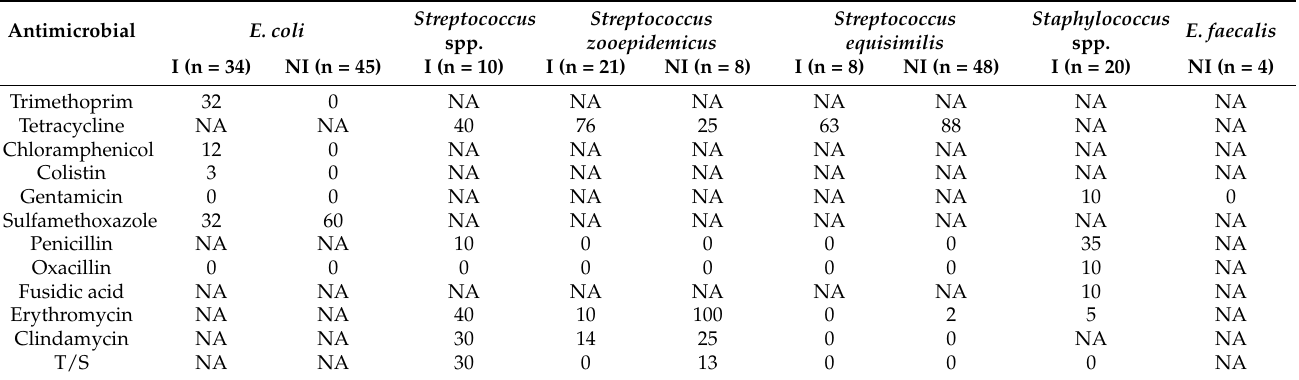
Table 6. Percentage of antimicrobial-resistant isolates of Escherichia coli , Streptococcus spp., Streptococ- cus equi subsp. zooepidemicus , Streptococcus equisimilis , Staphylococcus spp., and Enterococcus faecalis from the vaginas of healthy mares.